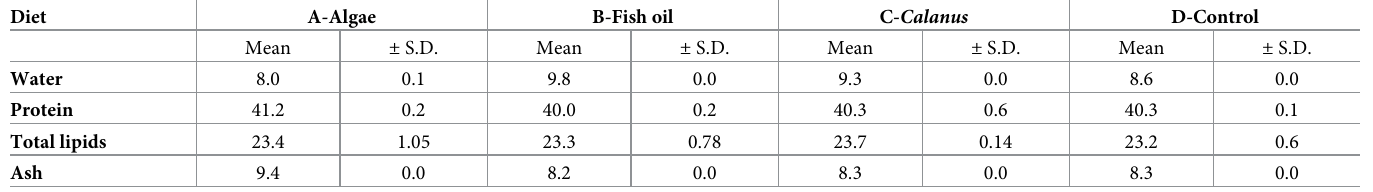
Table 3. Water, protein (sum of amino acid residues), ash and total lipid content as % of DW in the different diets, n = 5. Diet A-Algae B-Fish oil C- Calanus D-Control Mean ± S.D. Mean ± S.D. Mean ± S.D. Mean ± S.D. Water 8.0 0.1 9.8 0.0 9.3 0.0 8.6 0.0 Protein 41.2 0.2 40.0 0.2 40.3 0.6 40.3 0.1 Total lipids 23.4 1.05 23.3 0.78 23.7 0.14 23.2 0.6 Ash 9.4 0.0 8.2 0.0 8.3 0.0 8.3